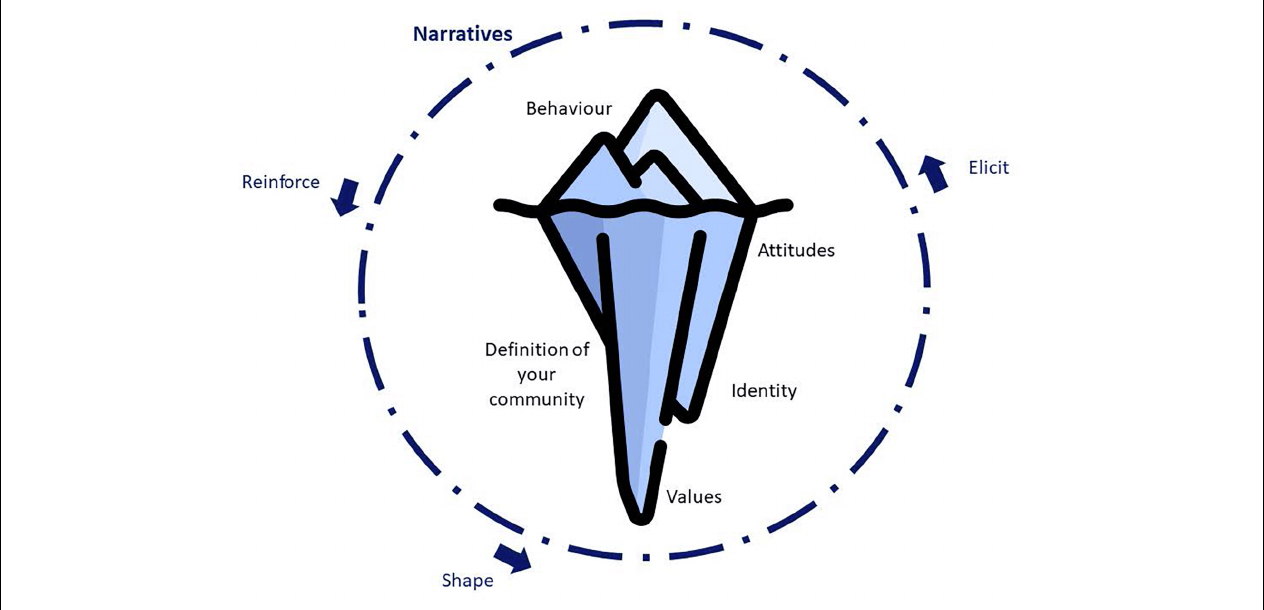
FIGURE 1 | The iceberg metaphor visualises the way a persons’ underlying value system shapes their identity, definition of community, attitudes and exhibited behaviours. Narratives play an important role here by shaping, eliciting, and reinforcing those underlying value systems.